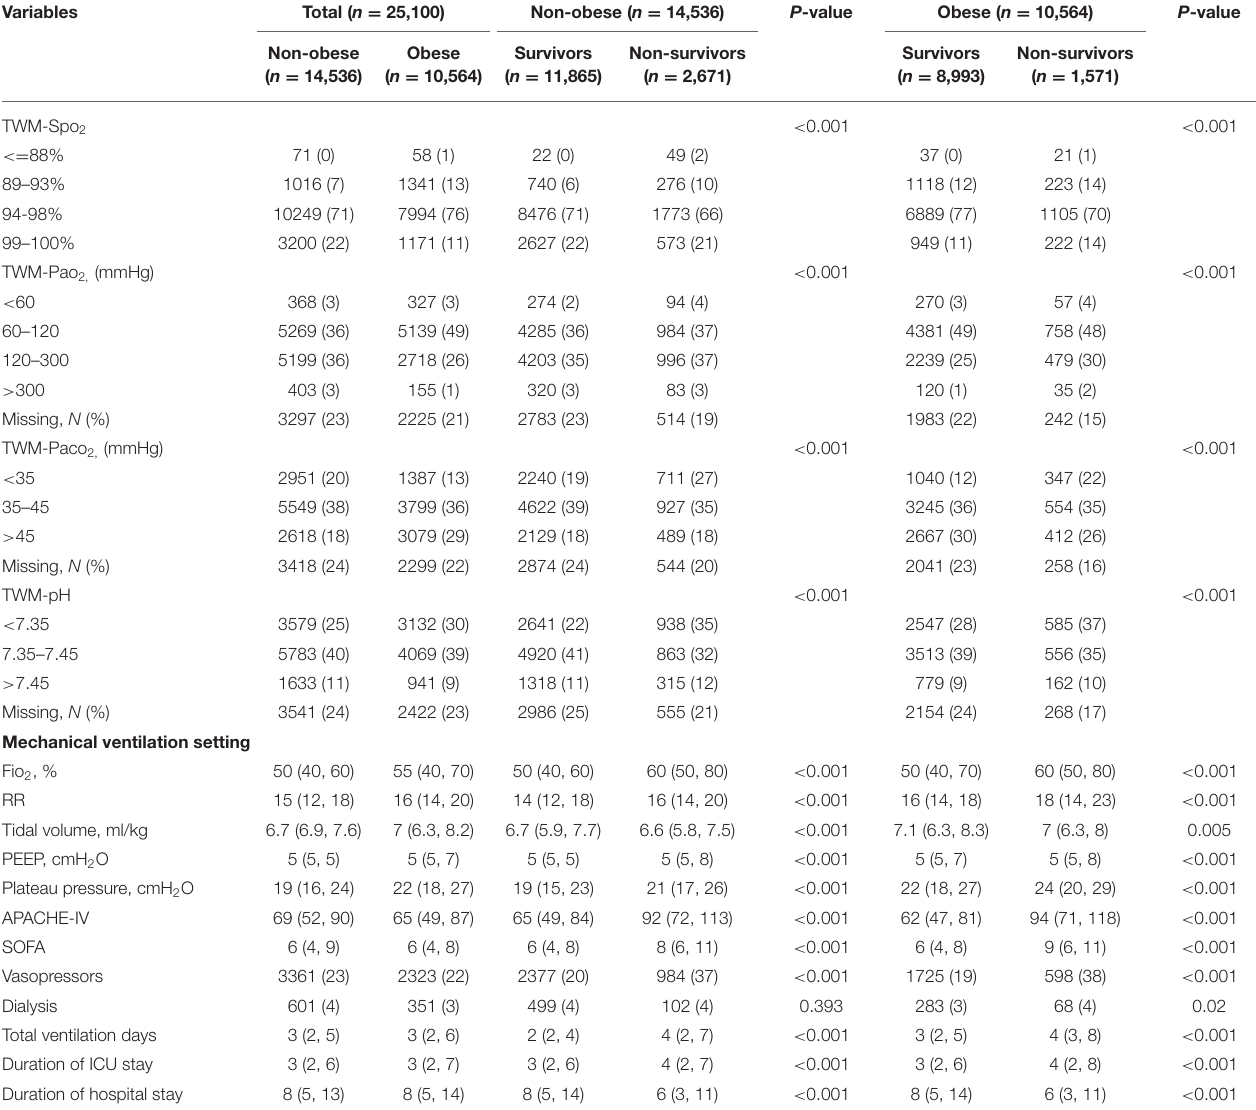
TABLE 2 | Clinical data during the first 24h and